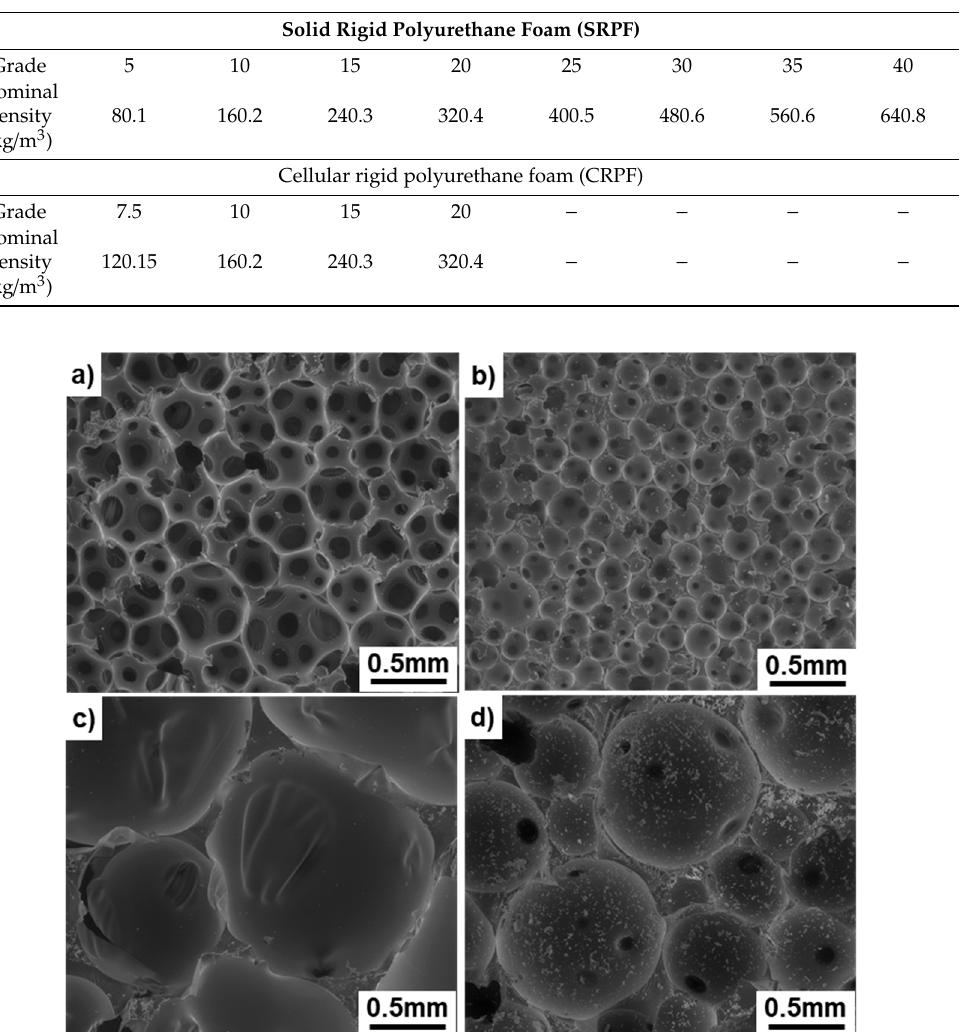
Figure 2. SEM images of solid rigid polyurethane foams (SRPFs) ( a ) T ‐ bone grade 5 and ( b ) grade 15 and cellular rigid polyurethane foams (CRPFs) ( c ) T ‐ bone grade 7.5 and ( d ) grade 20. and cellular rigid polyurethane foams (CRPFs) ( c ) T-bone grade 7.5 and ( d ) grade